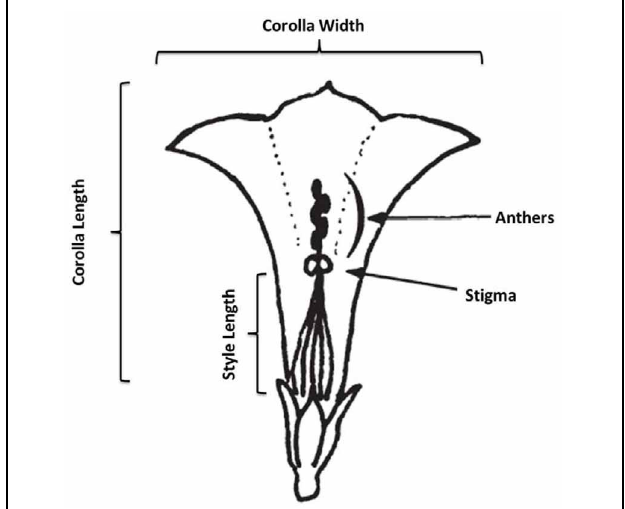
FIGURE 1 | Schematic of corolla measurements. In the figure anthers and stigma are not touching (anther-stigma distance = 1). Figure adapted from Abel and Austin